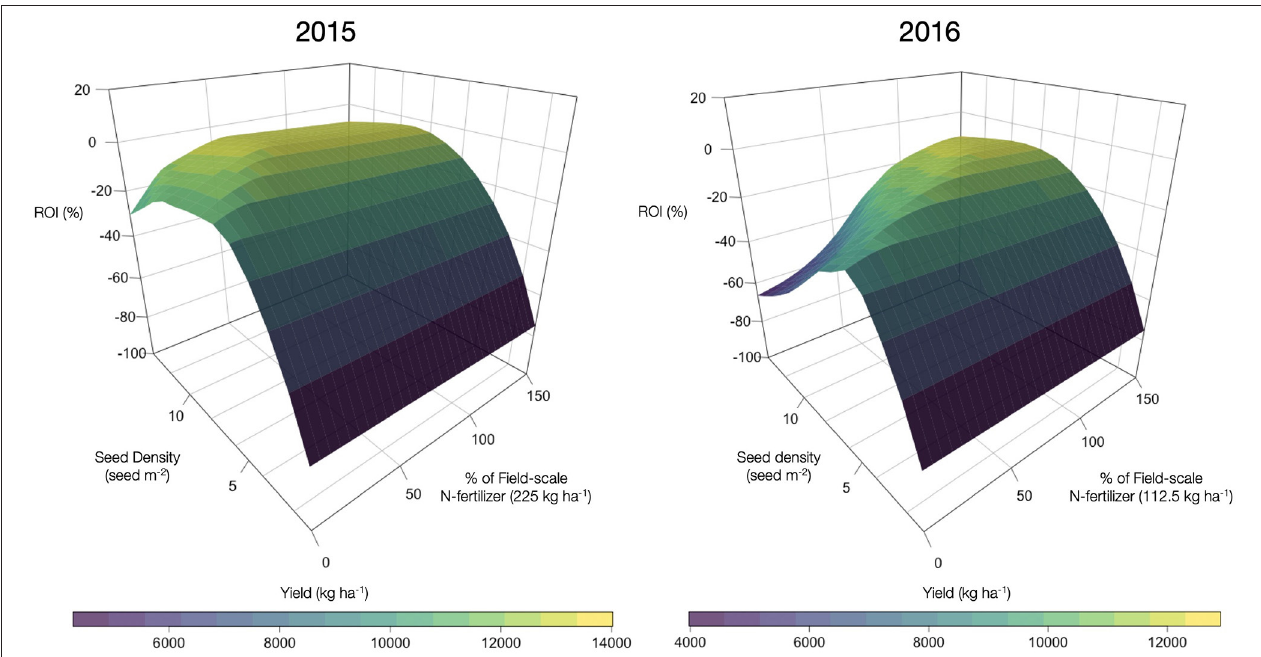
FIGURE 8 | An example of modeled yield and ROI response to variable seeding density and N-fertilizer rate combinations applied in 2015 and 2016. Data associated with the area-dominant subfield soil type within the North-central Iowa field is shown (Mukey 403374; 5.5 ha; see Figure 2 ).